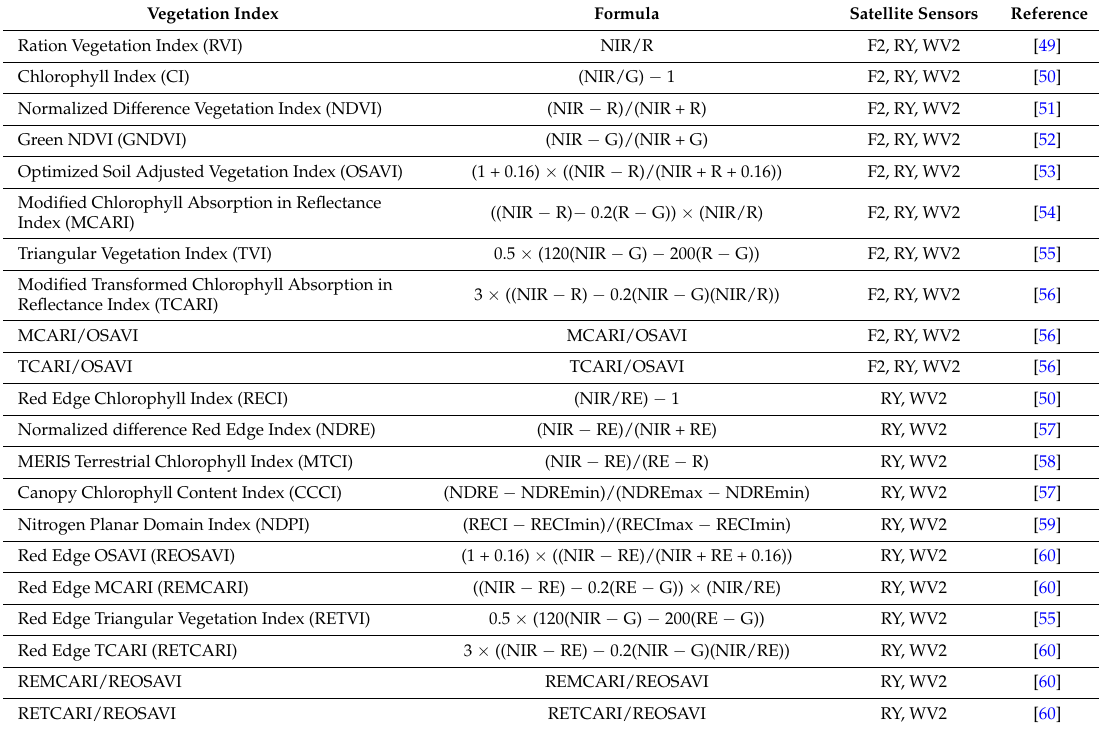
Table 3. Vegetation indices evaluated in this study for estimating rice N status indicators.